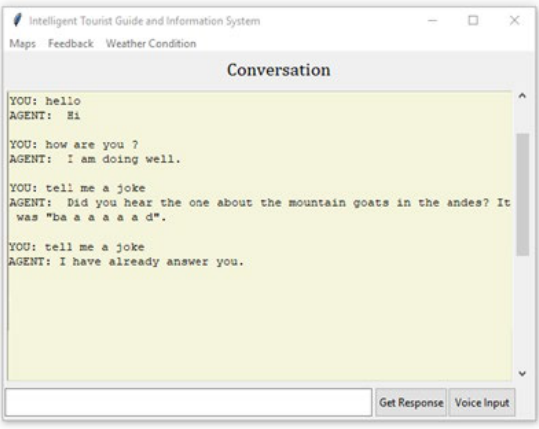
Fig. 8. Learning process and priority update by the agent.